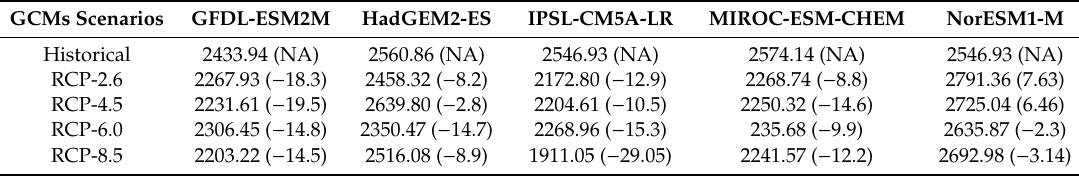
Table 7. Mean monthly historical (1971–2001) and future (2020–2050) discharge (cm 3 / s) and percent change of global climate models (GCMs) under all four future